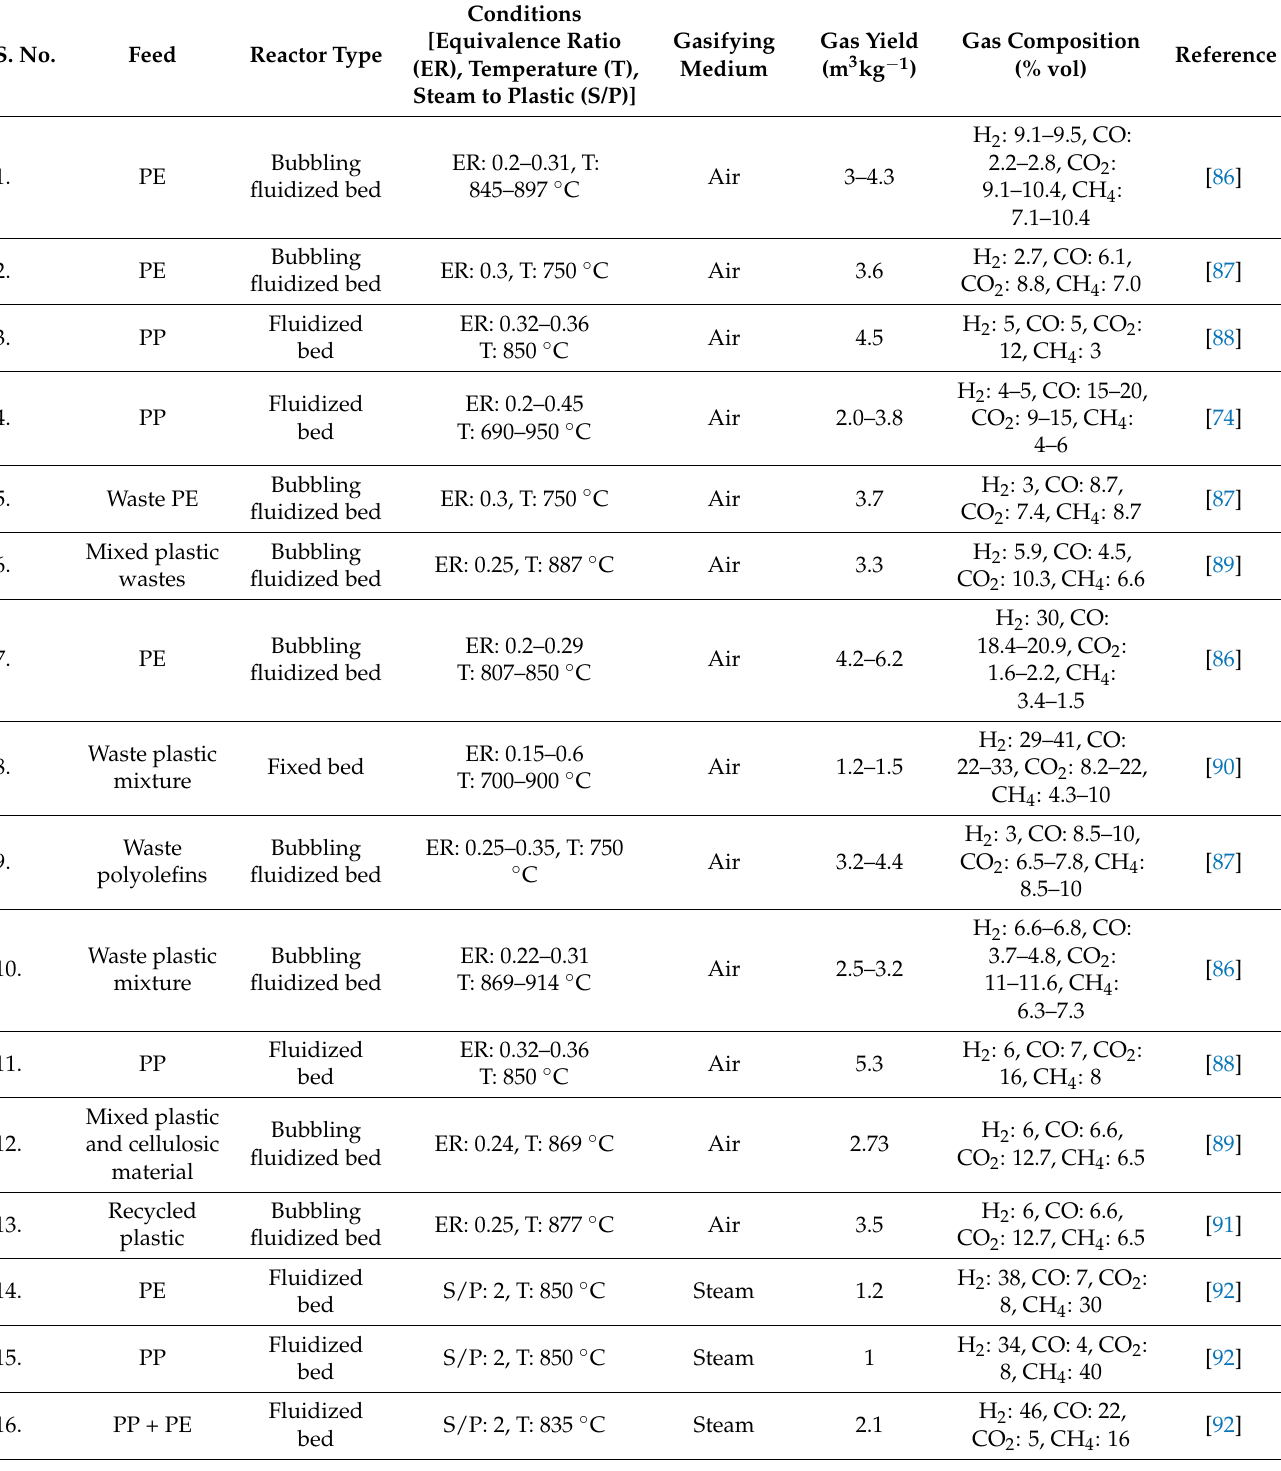
Table 6. Summary of plastic waste gasification studies carried out by various research groups around the